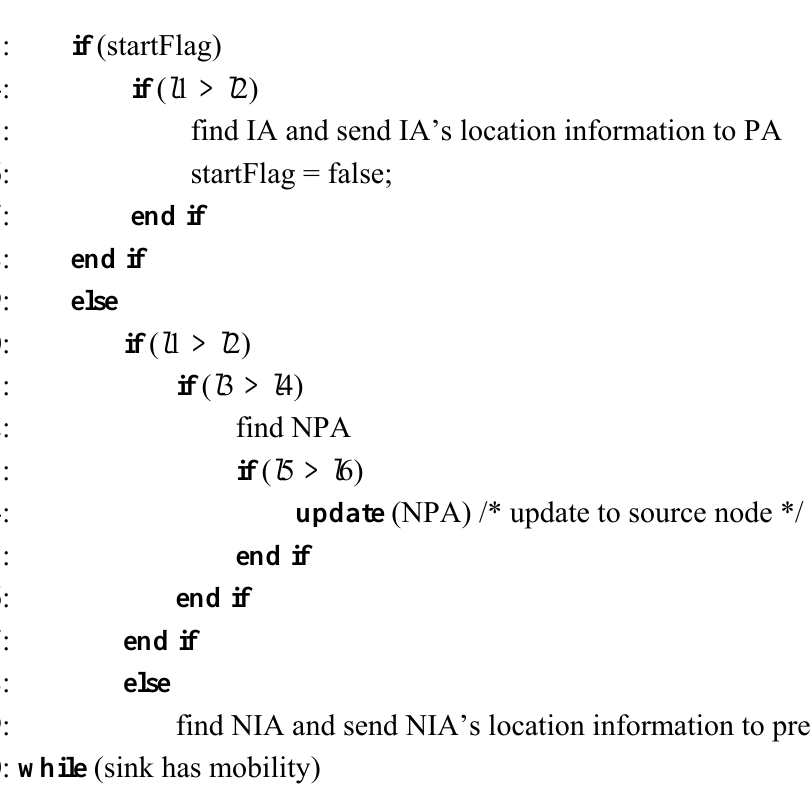
Algorithm 3-2. Pseudo-code to manual